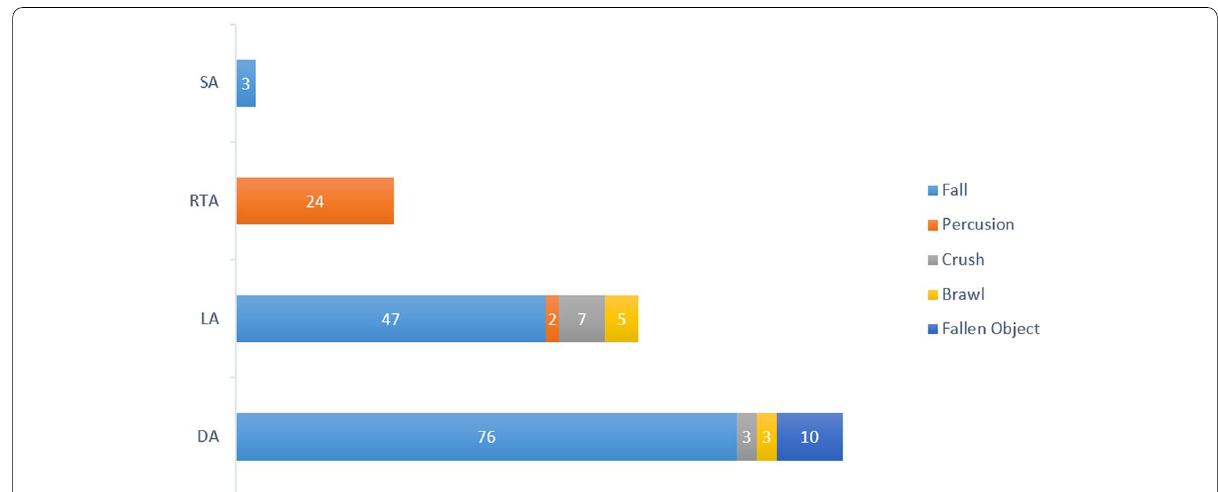
Fig. 1 Repartition of patients according to injury mechanism. DA, domestic accident; LA, ludic accident; RTA, road-traffic accident; SA, sport